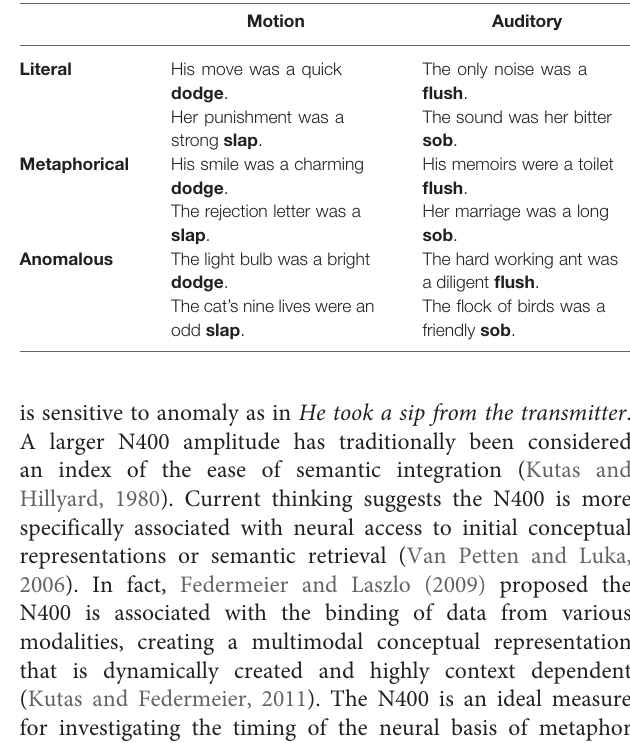
TABLE 1 | Examples of each sentence type